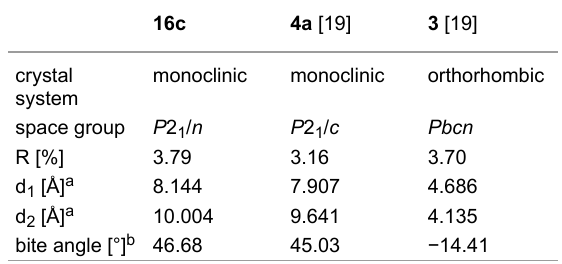
Table 1: Crystallographic details for 16c and related non-fluorinated